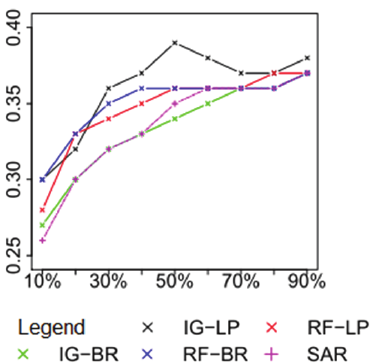
Figure 3: F-Measure performance of BRkNN-b